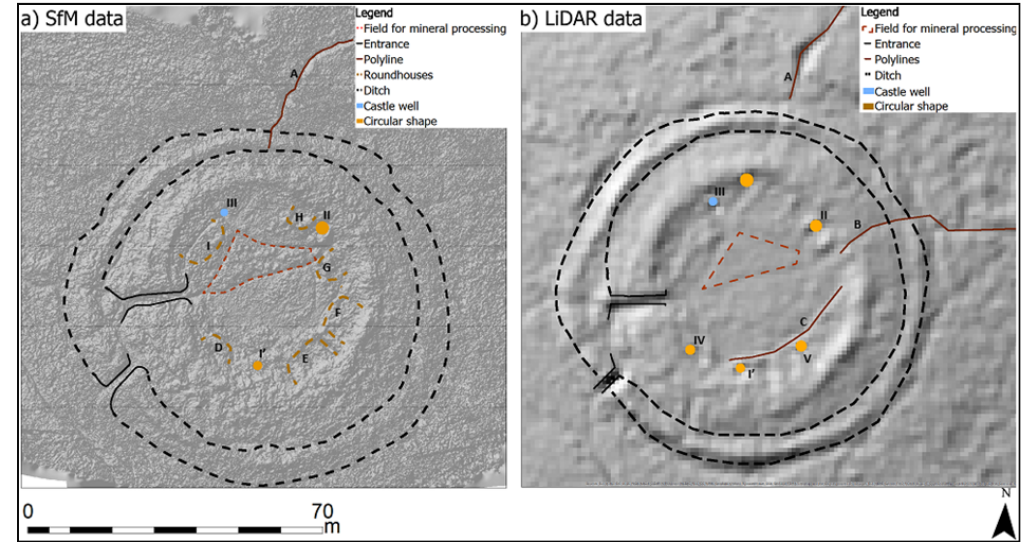
Figure 6. Results obtained from visual interpretation: Comprehensive interpretation map of Chun Castle applying manual digitizing based on shaded relief visualizing model: ( a ) Seven types of archaeological features were found and digitized using SfM data; ( b ) six features are detected using LiDAR data. Table 6. The areas of the archaeological features detected in this work using SfM and LiDAR data analysis. Feature